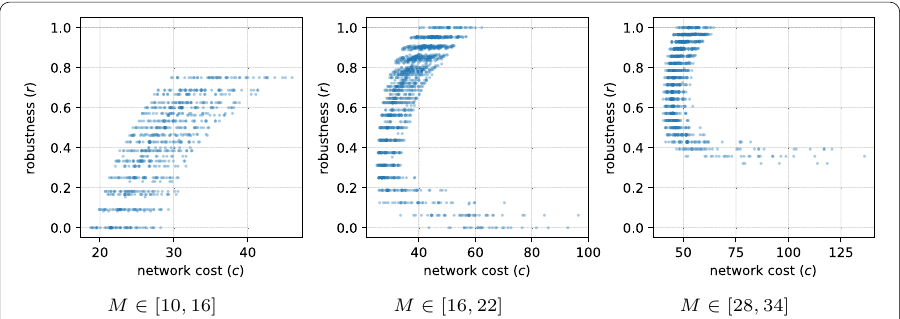
Fig. 4 Pareto fronts in a series of ( c , r ) optimizations with N = 20 and varying M boundaries. Each figure combines the results of 50 model setup runs that have different spatial distribution of